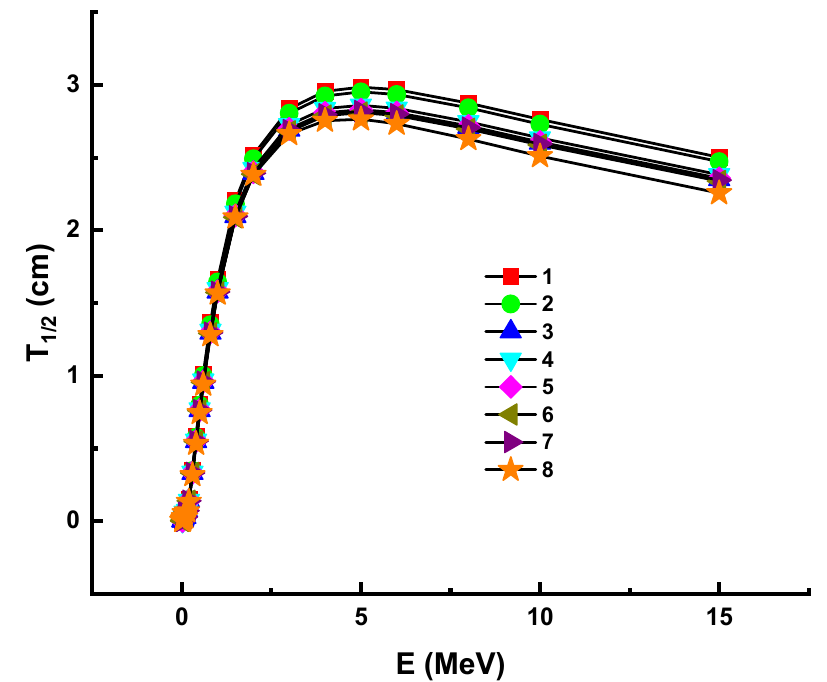
Figure 3. Variation of half value layer (T 1/2 ) against photon energy for all glasses. 1—37.5Bi 2 O 3 –62.5B 2 O 3 ;